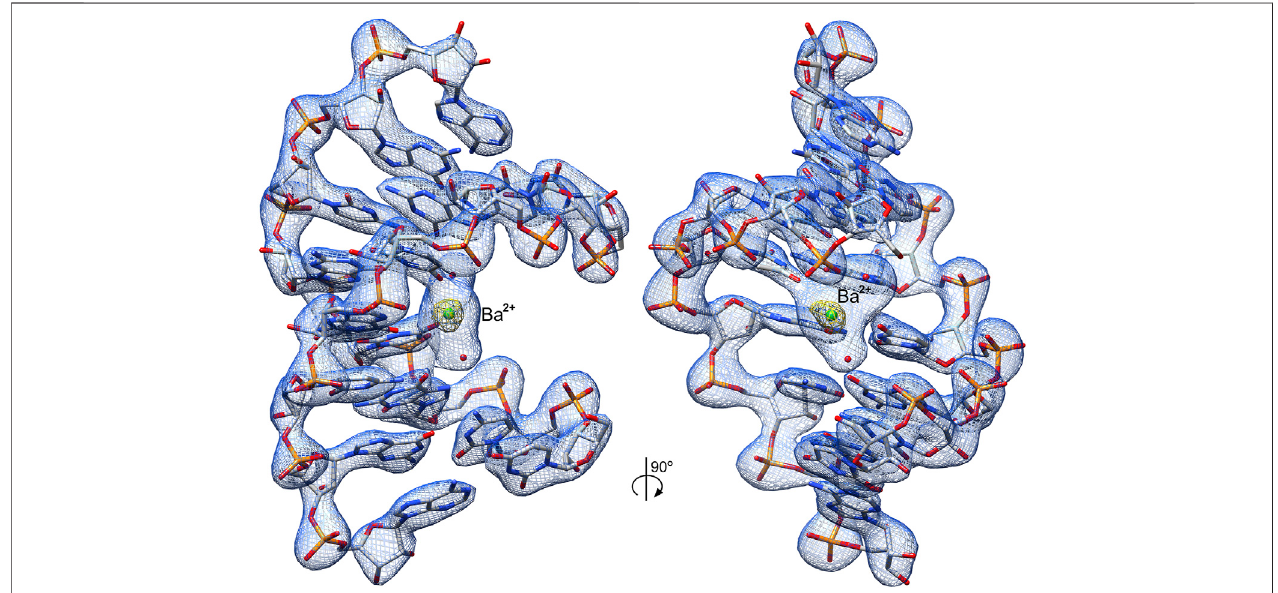
FIGURE2| Crystalstructureofther(UCGUGCGA) 2 duplex.Thestructurecontainsthe5 ′ UG/3 ′ GUwobbletandem constitutingthebindingsiteofBa 2+ ( greenball ) and two water molecules ( red balls ). The 2 F o – F c electron density map ( blue mesh ) around the RNA duplex is contoured at the 1.5 σ level. The anomalous difference electron density map ( yellow mesh ) is shown at the 7 σ level; the strong map peak veri fi es the presence of Ba 2+ .